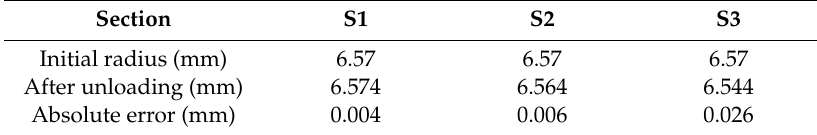
Table 3. Curvature radii of the separated arc segments after springback.